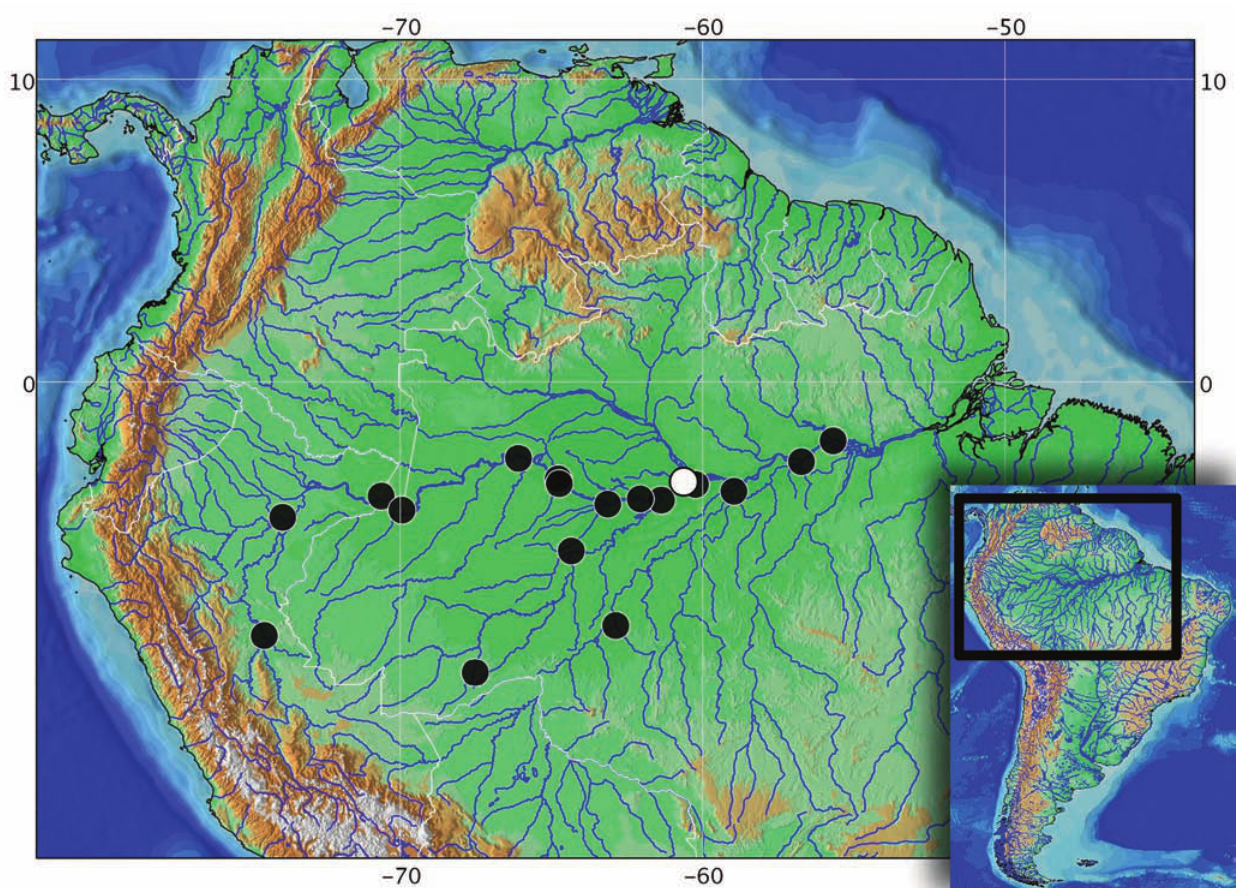
Fig. 3. Map of northern South American showing the distribution of Leporinus jamesi . White symbol represents the type